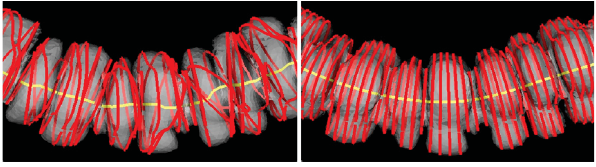
Fig. 3 Yellow curve: centerline. Red curves: cross sections. The GC surface is a human colon segmented from CT. Left: centerline computed by Refs. [24, 42, 43], with large and discontinuous curvatures, leading to intersections. Right: centerline modified according to the relative curvature condition, without intersections between cross sections.